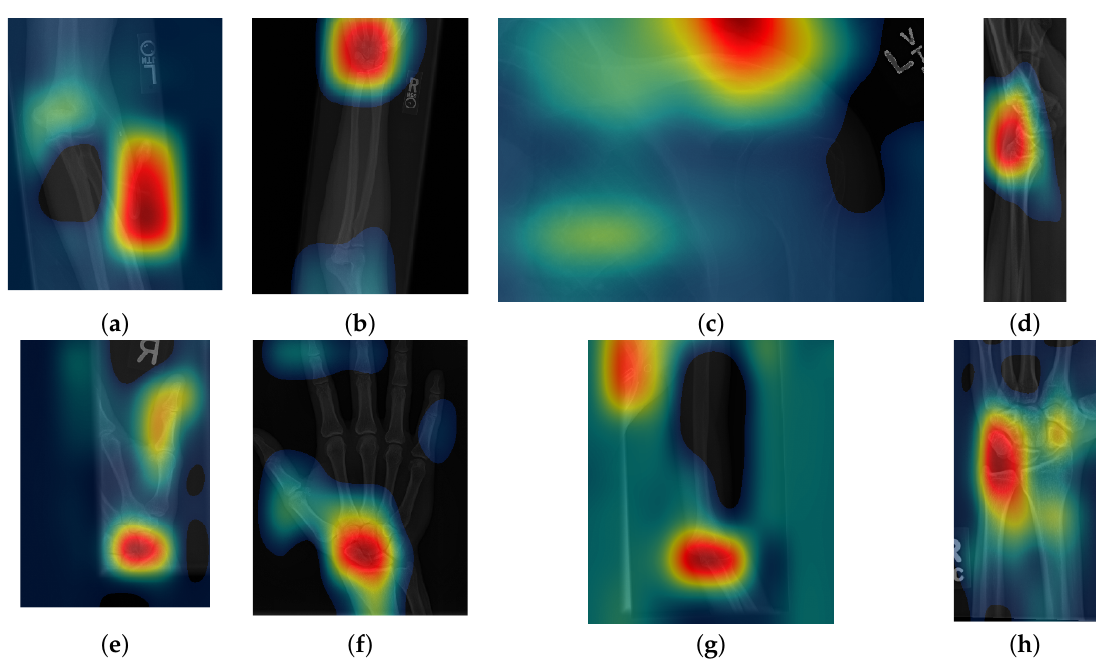
Figure 9. Illustration of activation maps overlaid over the eight radiographs without abnormalities of Figure 1 to indicate the regions of the image that activated an Inception-ResNet-v2 architecture. ( a ) Elbow, ( b ) Forearm, ( c ) Shoulder, ( d ) Wrist (lateral view), ( e ) Finger, ( f ) Hand, ( g ) Humerus, ( h ) Wrist. It should be noted that the activation regions are more localised than those of the ResNet 50.